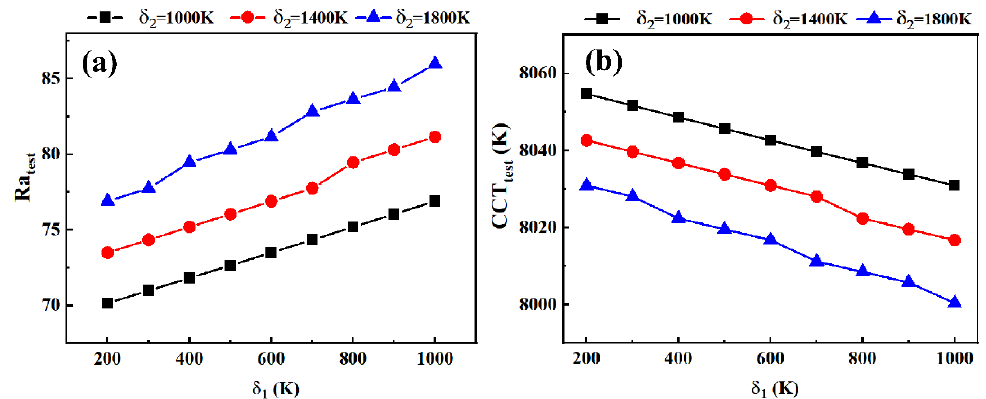
Figure 4. ( a ) Variation in Ra test under different δ 1 values, when δ 2 equals to 1000 K, 1400 K, and 1800 K, respectively; ( b ) variation in CCT test under different δ 1 values, when δ 2 equals to 1000 K, 1400 K, and 1800 K, respectively.